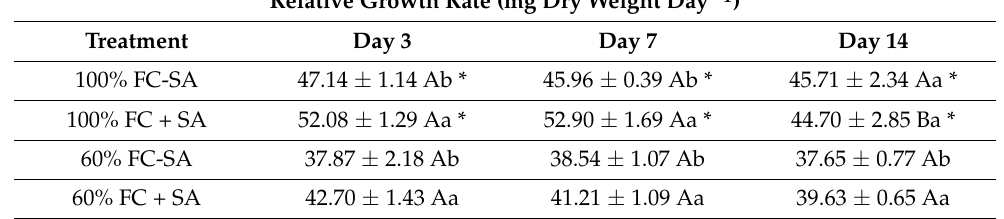
Table 1. Relative growth rates of A. chilensis plants grown under 100% and 60% FC and two SA doses (0 and 0.5 mM) at different times post SA